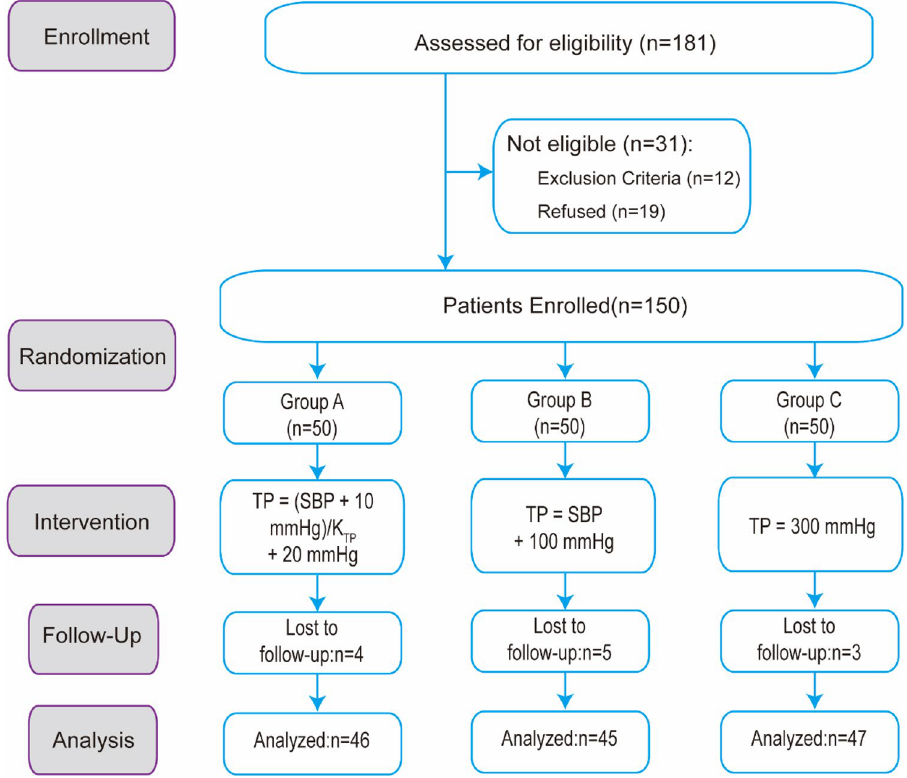
Figure 4. CONSORT (Consolidated Standards of Reporting Trials) flow diagram of patients eligible and intervention of this study. TP, tourniquet pressure. SBP, systolic blood